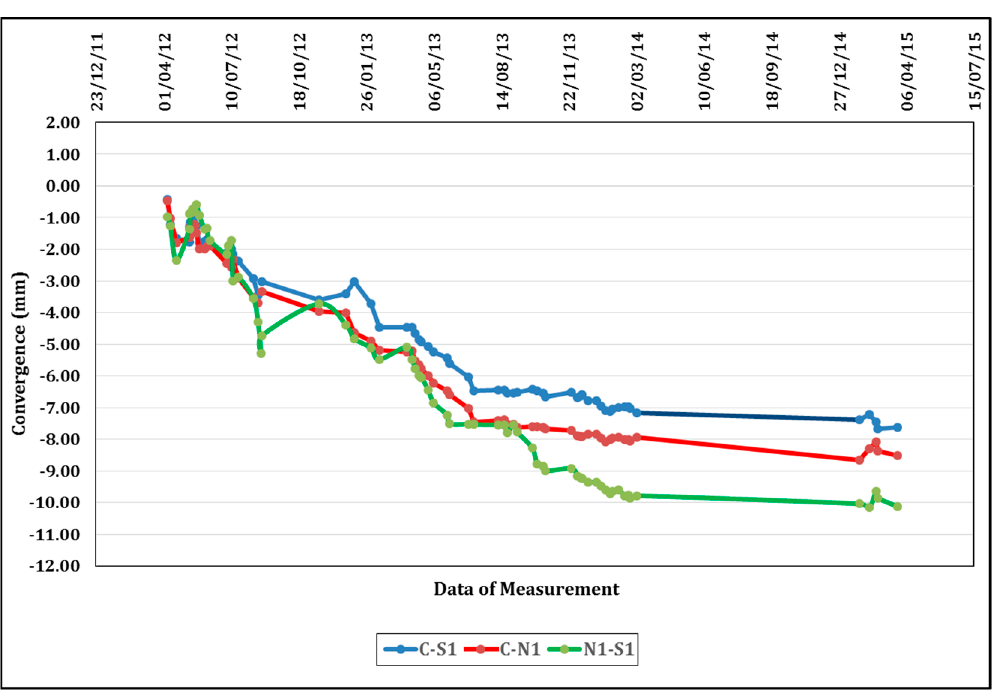
Figure 7. The amount of tunnel convergence at the chainage 1 + 787 of KUR in relation to time.